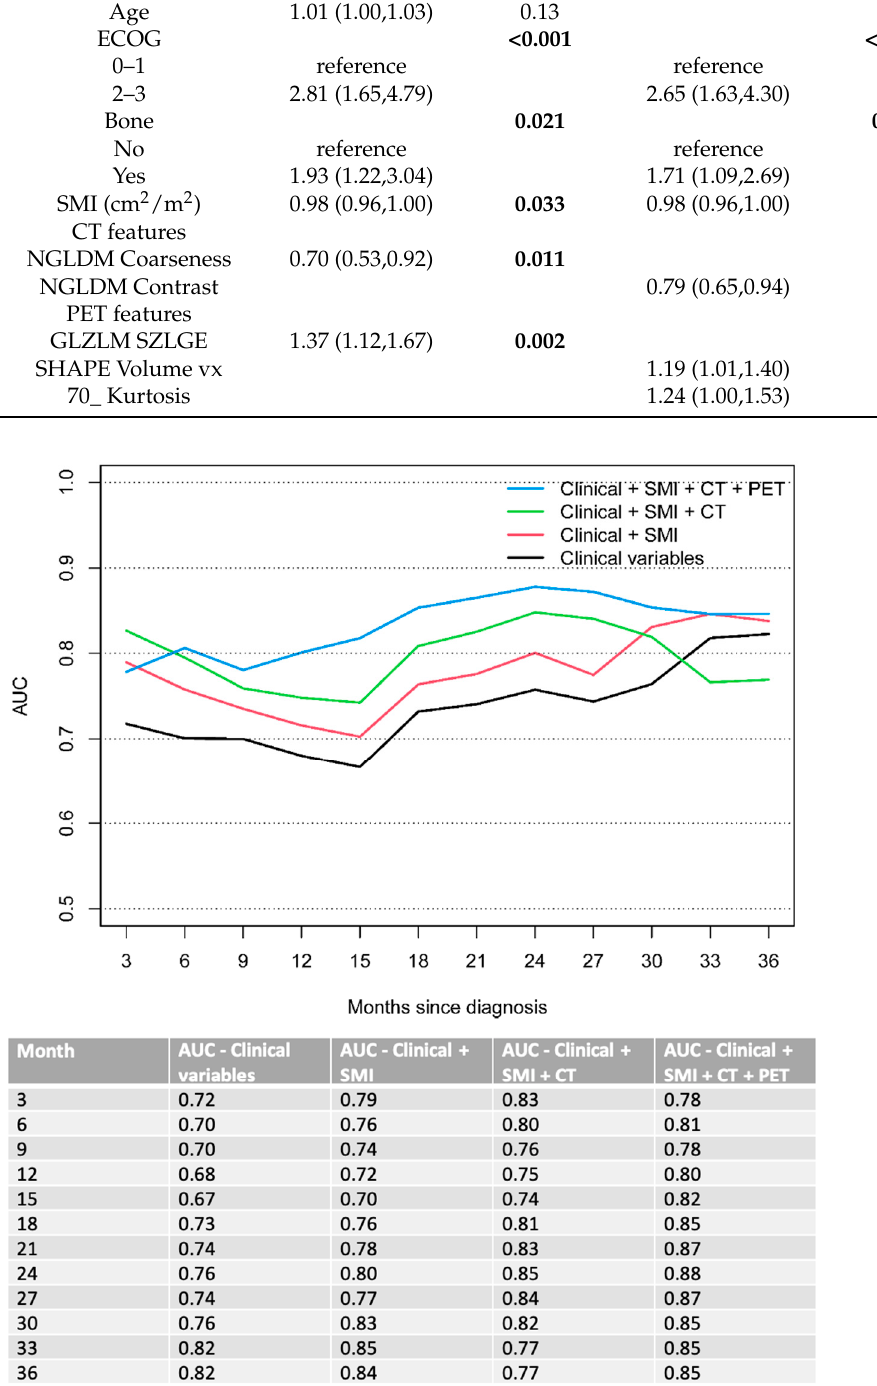
Figure 2. Time-dependent AUC for OS. Clinical variables include ECOG performance status and bone metastases.